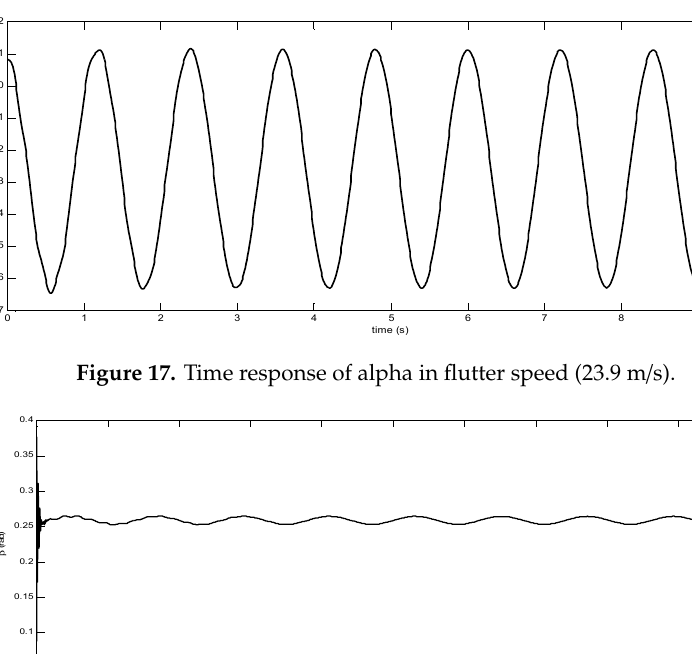
Figure 18. Time response of beta in flutter speed (23.9 m/s).